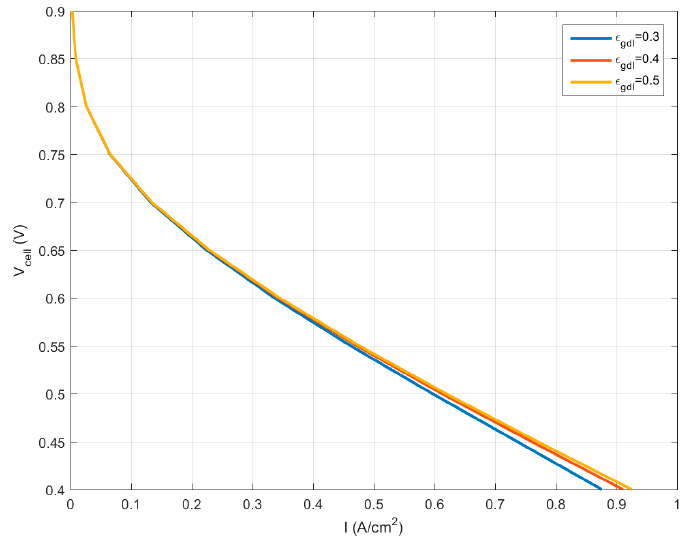
ff ect of GDL porosity on the HT-PEMFC performance at 180 ◦ Figure 8. Effect of GDL porosity on the HT-PEMFC performance at 180 °C. Figure 8. E